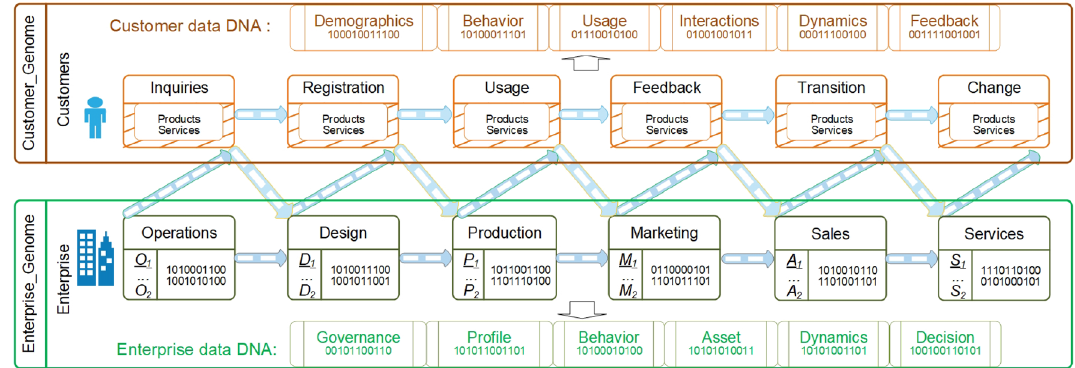
Figure 2. Learning enterprise representations to capture the universal, representative and benchmarkable data genomes of an enterprise and their customers: enterprise data DNA, and customer data